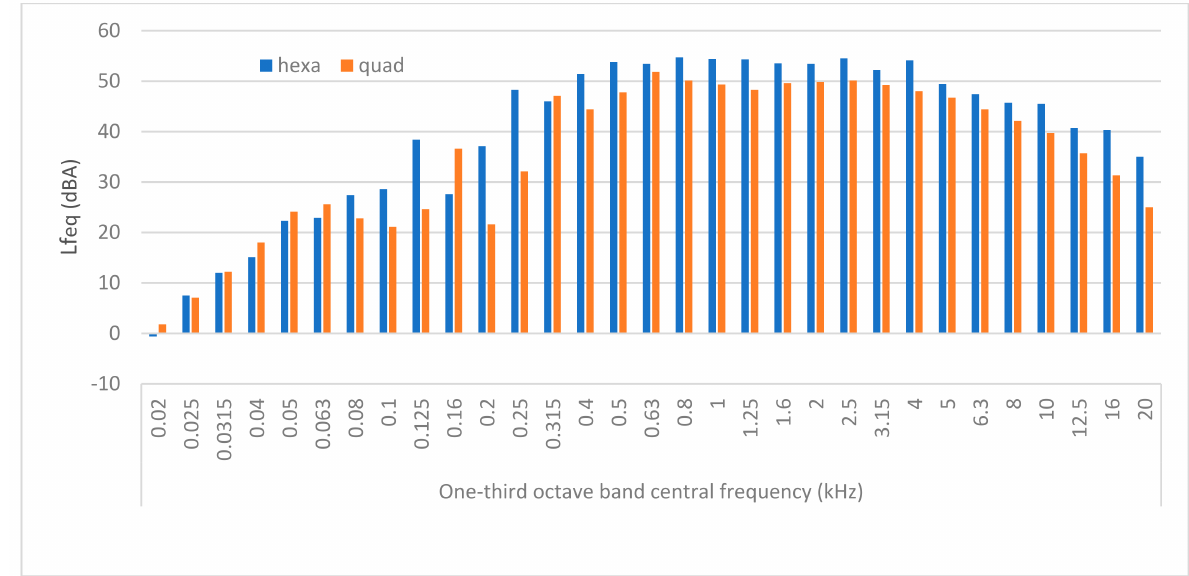
Figure 6. One-third octave band spectrums for both drones during the hovering procedure.